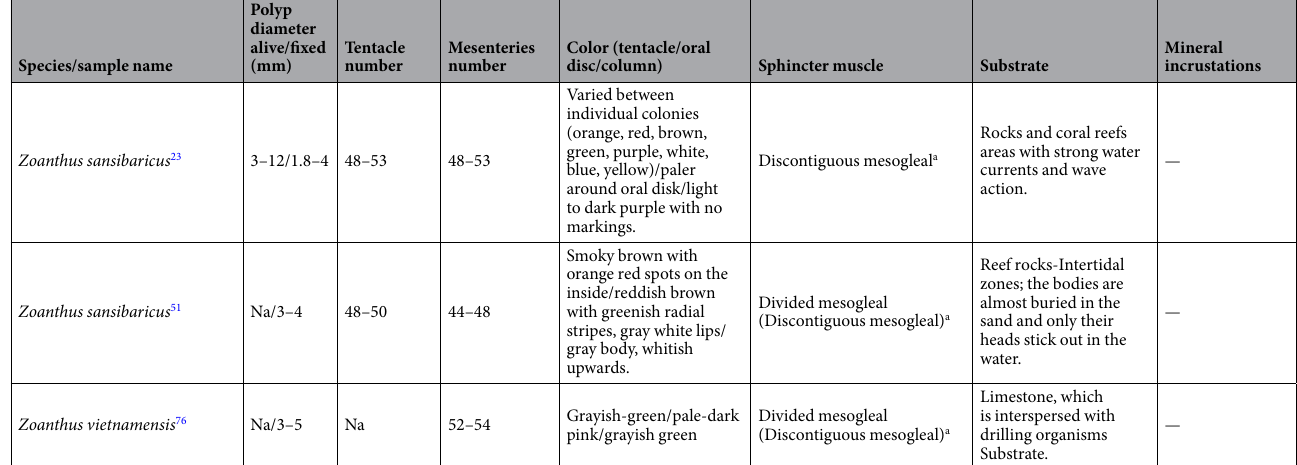
(Table 2). Compared to the sequences published in the original description of P . darwini , Z1-2 (780 bp) was identical to sequences EU333801 and EU333802 (635 bp), while sequences EU333799 and EU333800 (636 bp)